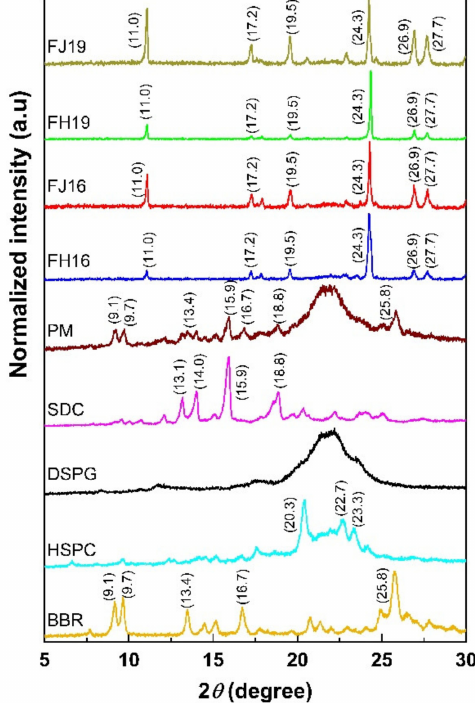
Figure 10. XRPD patterns of berberine (BBR) in powder form, distearoyl phosphatidylglycerol (DSPG), hydrogenated soy phosphatidyl choline (HSPC), physical mixture (PM) of BBR, HSPC, DSPG and SDC and BBR-loaded liposomes generated by the ethanol-injection (FJ16, FJ19) and thin-film hydration methods (FH16,